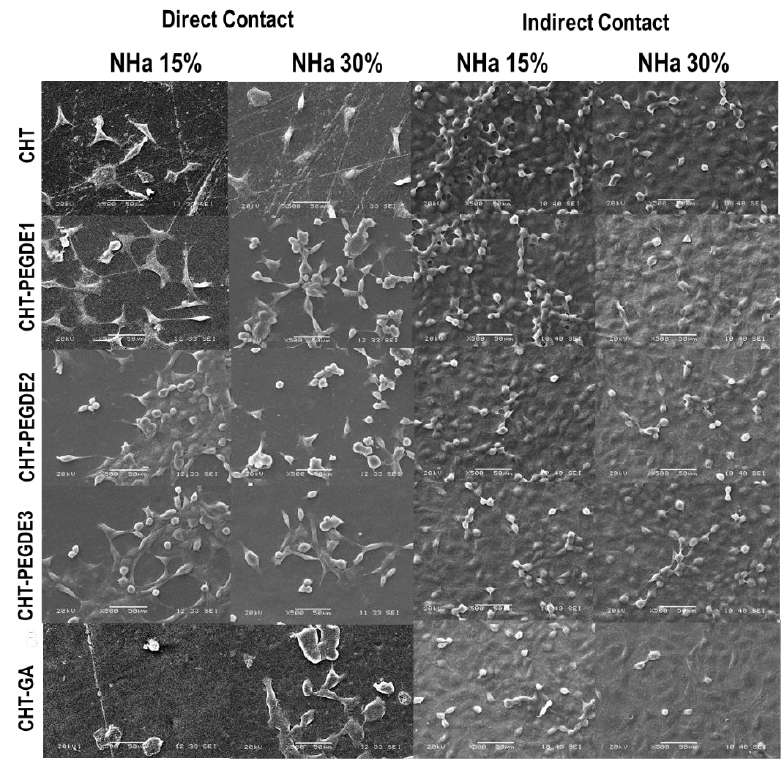
Figure 8. SEM images of osteoblast seeded onto CHT scaffolds on direct and indirect contact.